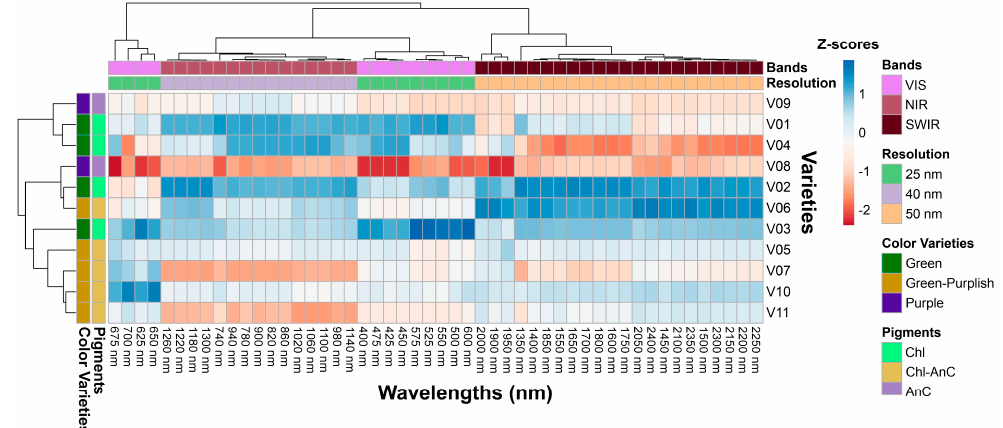
Figure 5. Cluster heatmap shows the correlation between the spectral bands, lettuce varieties, and pigment concentrations (chlorophylls, chlorophylls–anthocyanins, anthocyanins). The correlations are organized by wavelength range (VIS, NIR, SWIR), spectral resolution (25, 40, 50 nm), and colour variety (green, green-purple, purple). Positive relationships are shown in blue (Z-scores p < 0.001) while negative correlations are shown in red.